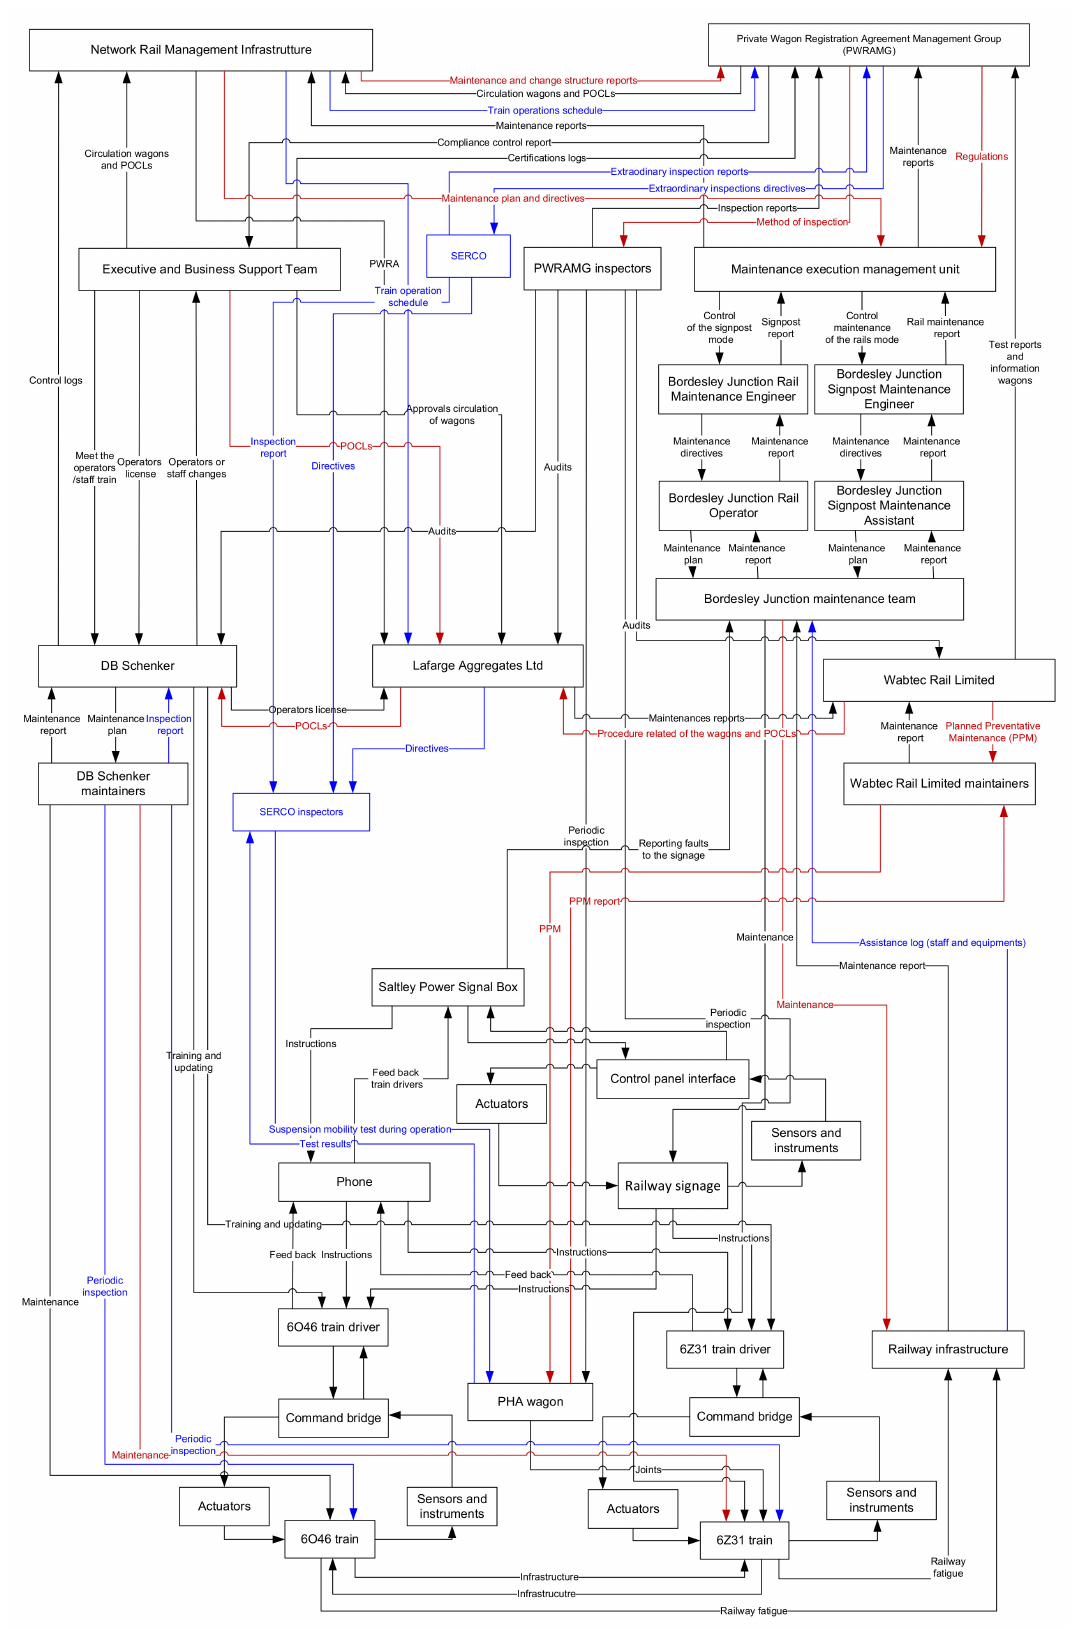
Figure 7. Updated SCS: in red the control actions or feedback performed inadequately or missing; in blue additional recommended control actions or